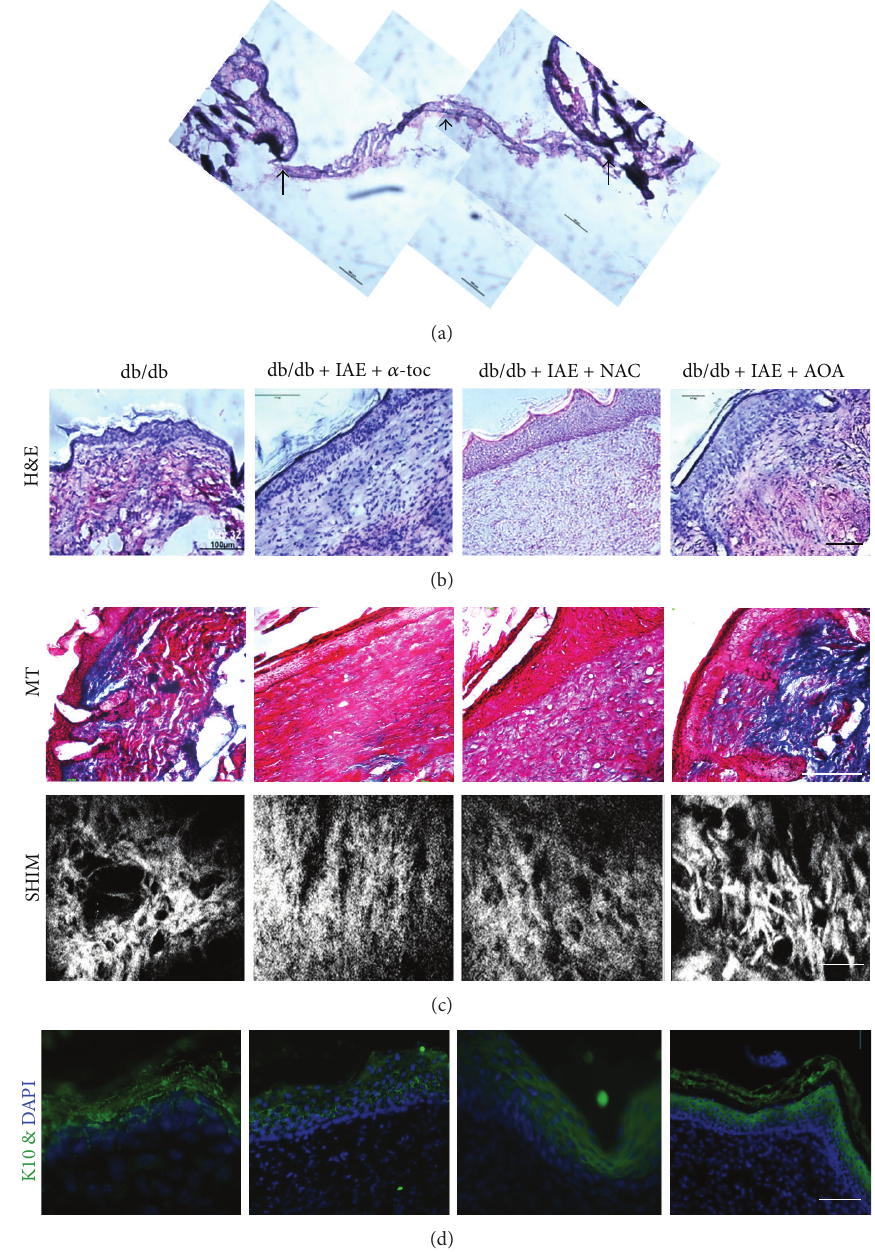
Figure 6: Histological evaluation of normal, chronic, and treated wounds: (a) H&E-stained section of day 64 chronic wound in db/db mice treated with IAE. (b) H&E-stained sections of representative animals to illustrate the histology at wound closure of db/db wounds from a nontreated animal (panel 1), an animal treated with IAE, and then with AOA 𝛼 -toc (panel 2), an animal treated with IAE, and then with AOA NAC (panel 3) and an animal treated with IAE and then both AOA (panel 4). Scale bar 100 𝜇 m. (c) Representative Masson-trichrome staining (blue color) illustrating loss of collagen deposition in nontreated db/db mice (panel 1). A decrease in collagen deposition was seen in chronic wounds treated with AOA individually (panels 2 and 3). Chronic wounds treated with both AOA had a significant increase in collagen deposition and fibril formation (panel 4). Second Harmonic Generated Imaging (SHIM) shows abnormalities in collagen bundles in the nontreated db/db wounds whereas no clear fibers are seen in individual AOA treated wounds. In wounds with both AOA, fibers are well formed and appear more mature. For SHIM the scale bar is 10 𝜇 m. (d) Keratin 10 illustrates the presence of the epithelial cytoskeleton in the terminally differentiating epithelial cells found in the suprabasal layer. The epithelium is much more mature in the wounds treated with both AOA. Scale bar is 100 𝜇